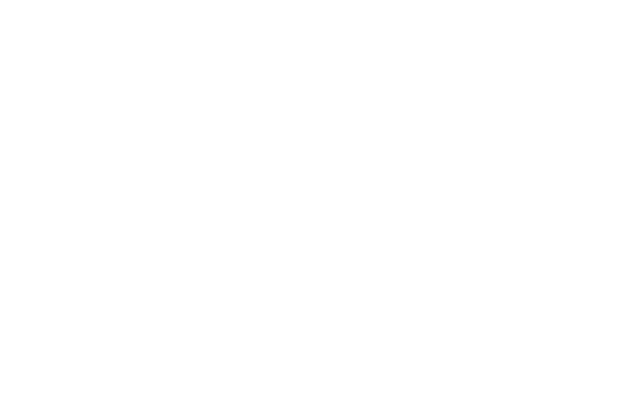
Figure 2. Growth of C. acnes from 3 × discs of the same sheep (USDA#1283) four weeks after initial inoculation. Data is presented as mean ± SEM of log 10 CFU per disc. Statistical analysis was performed for paired samples.